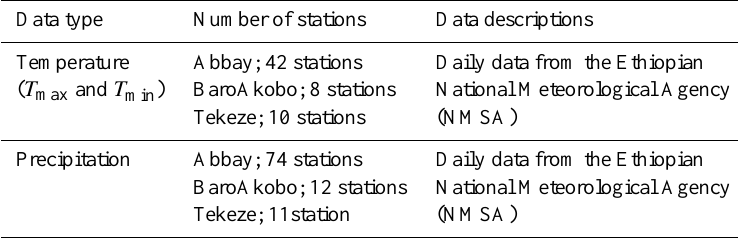
Table 2. Meteorological data sources for Eastern Nile basin.